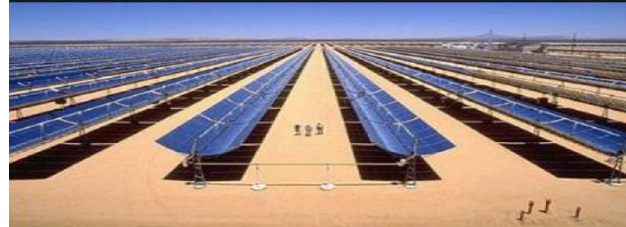
Fig. 1. NOOR 1 (Concentrated Solar